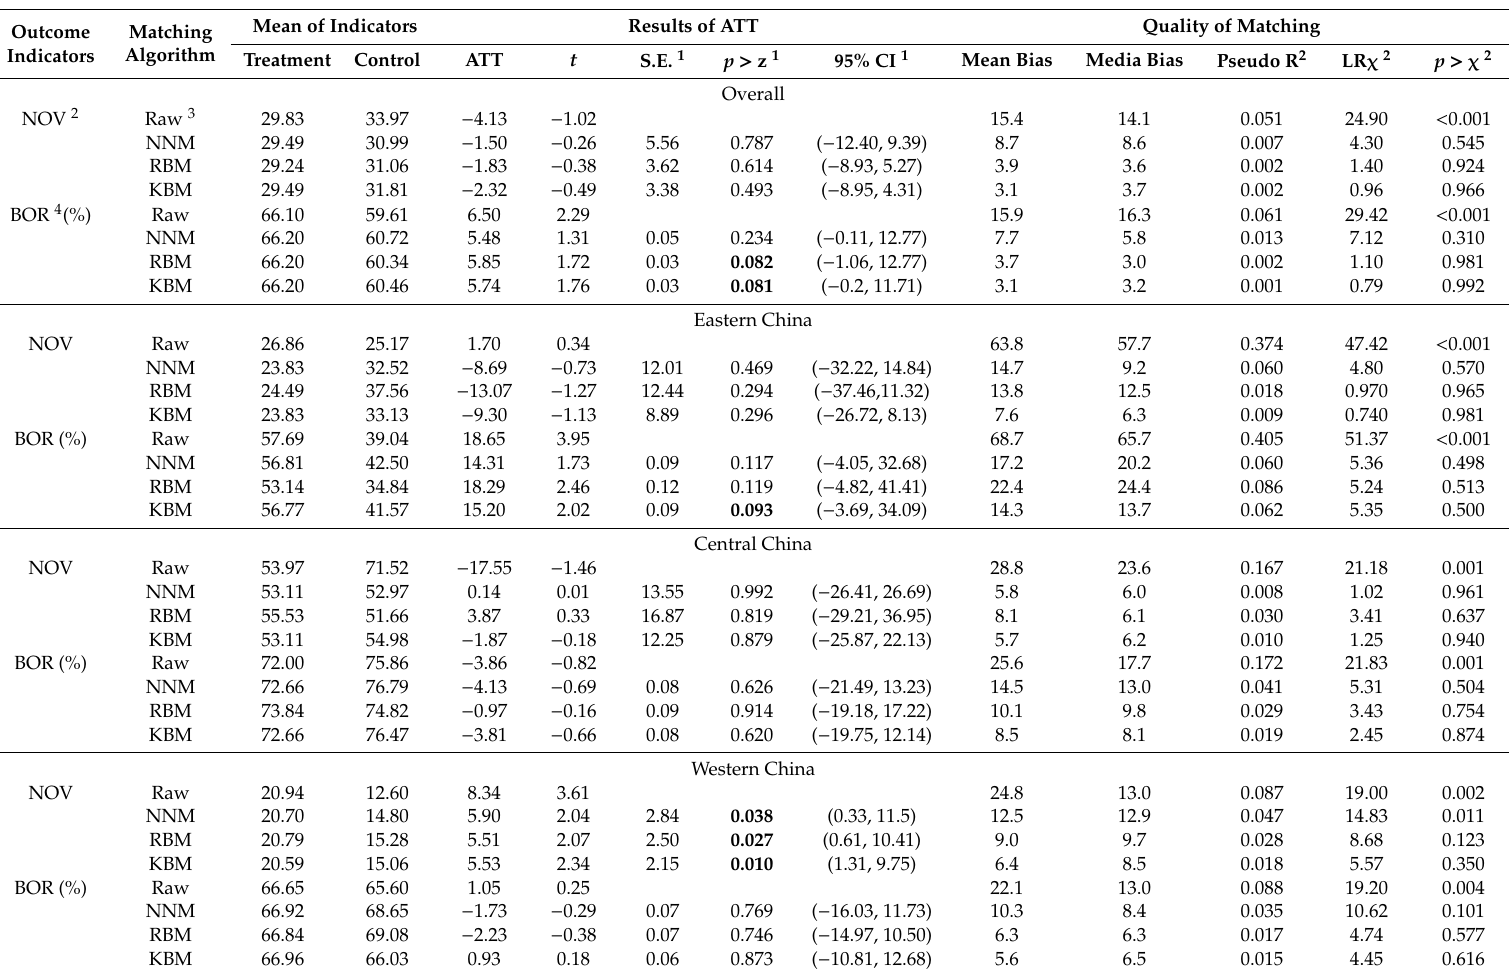
Table 4. Results of propensity score